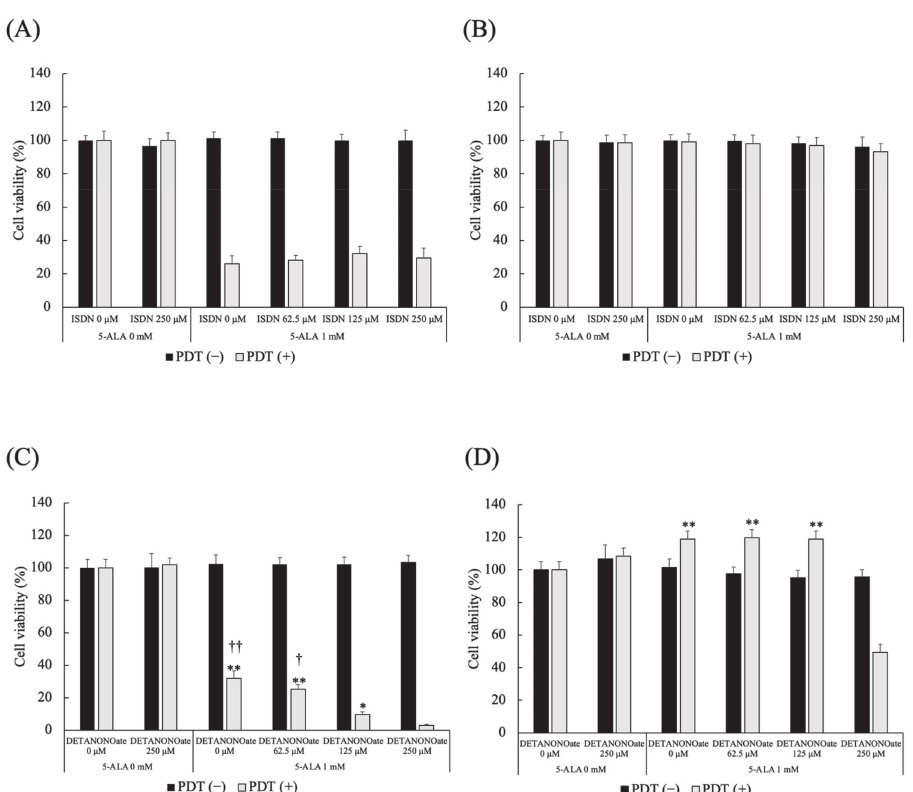
Figure 8. Effect of NO donors on 5-ALA-mediated PDT-induced cell death. ( A , B ) Isosorbide dinitrate (ISDN) and ( C , D ) DETA NONOate. ( A , C ) HDC and ( B , D ) LuBi cells. Results are presented as mean ± standard deviation ( n = 6). Groups were compared using Sidak’s multiple comparison test, * p < 0.05, and ** p < 0.01 vs. DETA NONOate 250 µ M. † p < 0.05, and †† p < 0.01 vs. DETA NONOate 125 µ